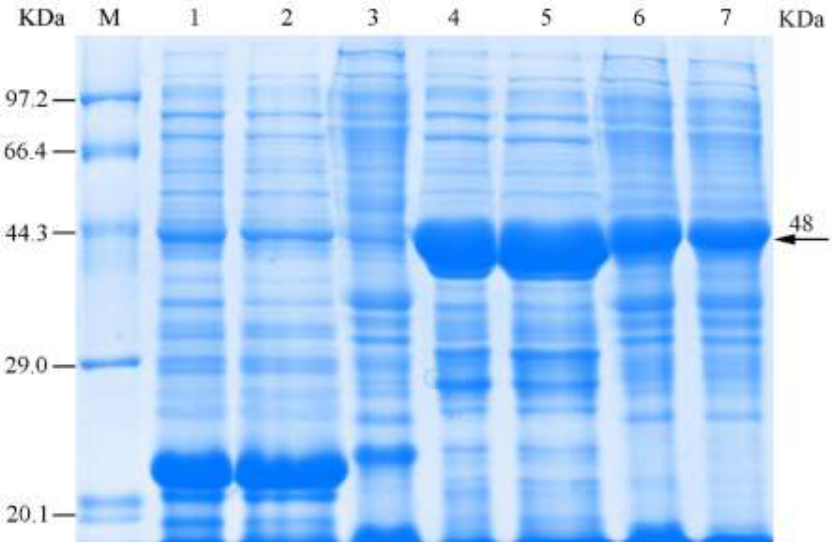
Figure 7. The detection of soluble recombinant proteins induced at 16 ℃ M: Protein marker (low molecular weight standard); 1, 2: Supernatant of cell lysate from a strain harboring pET32a (+); 3: Sediment of cell lysate from a strain harboring pET32a(+); 4, 5: Supernatant of cell lysate from a strain harboring the recombinant vector; 6: Sediment of cell lysate from a strain harboring the recombinant vector.